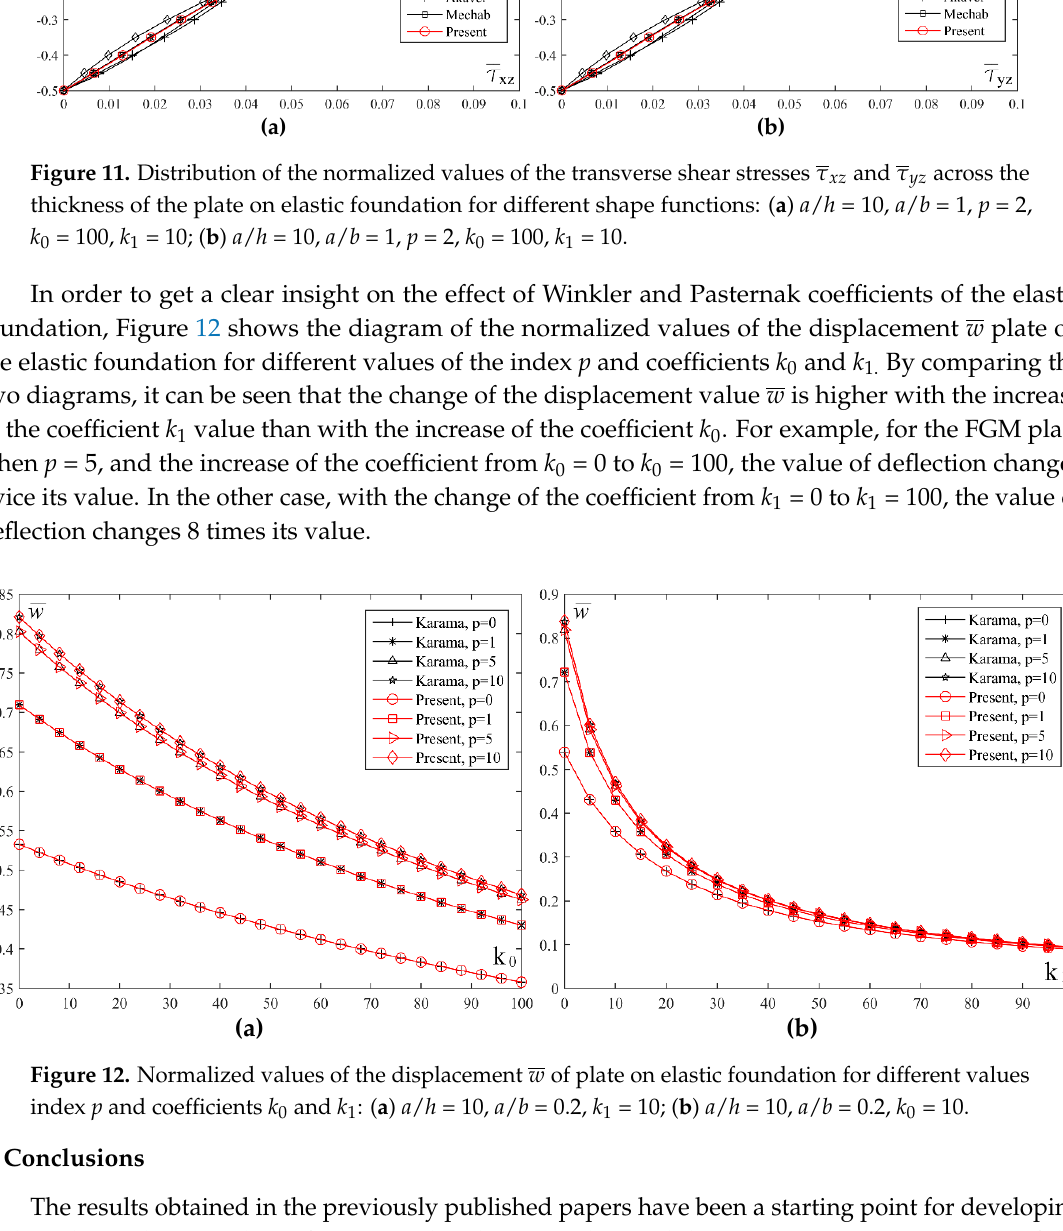
τ and across and τ across yz xz yz xz